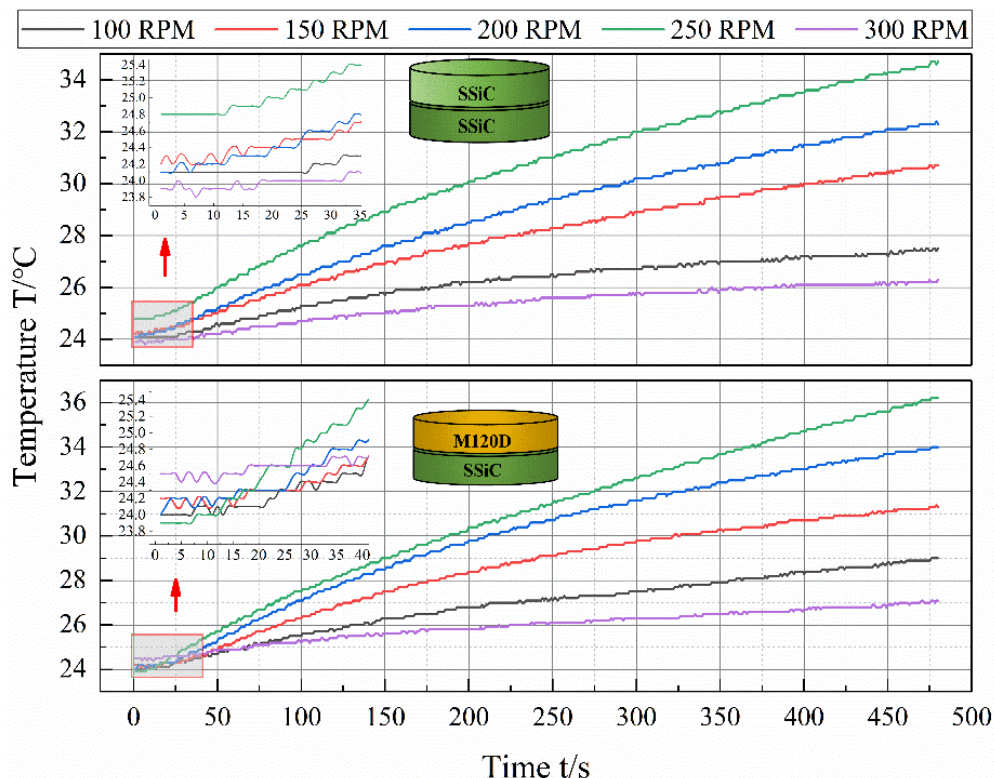
Figure 5. Surface temperature of friction pairs with different materials under 100–300 rpm.